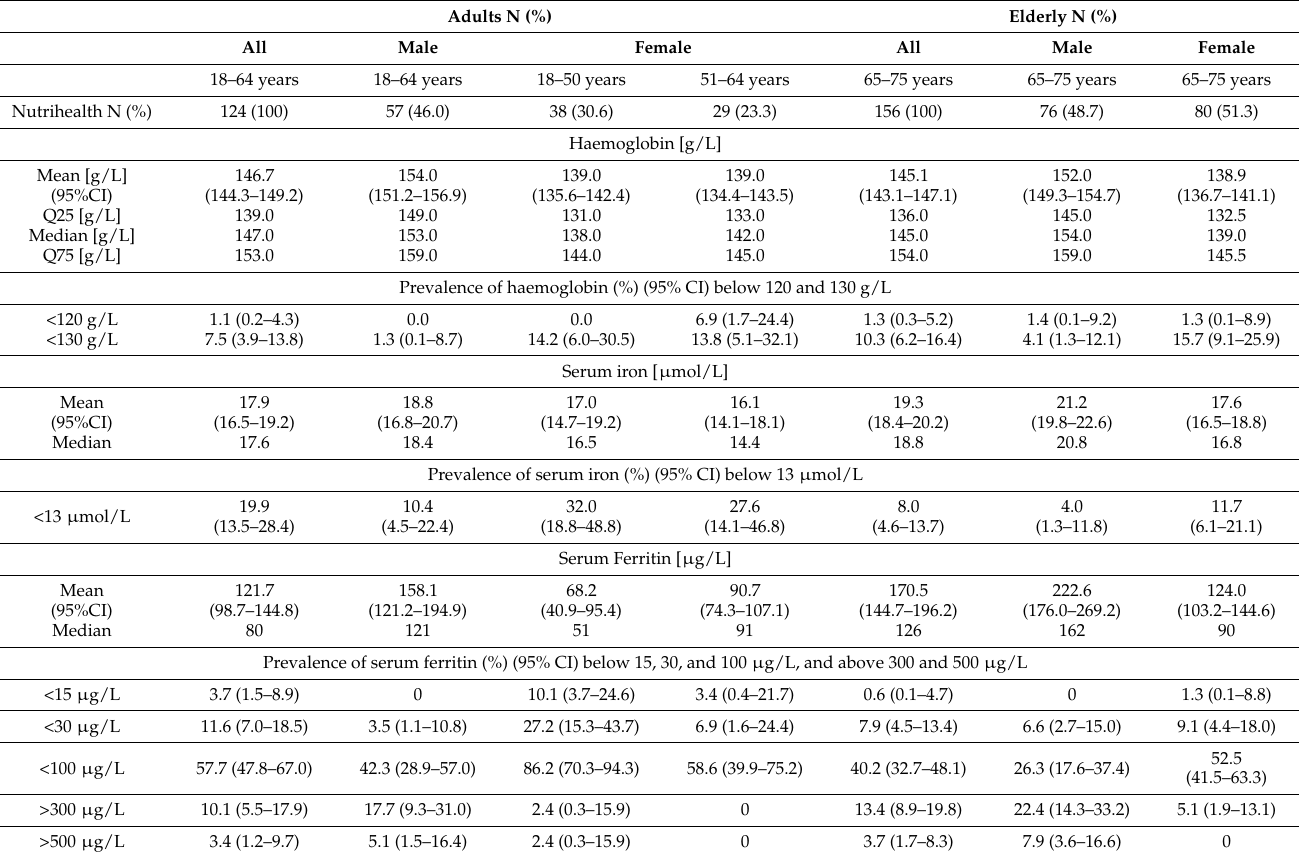
Table 3. Population-weighted mean haemoglobin, serum ferritin, and serum iron concentration, and the prevalence of low haemoglobin, low serum iron, and low/high ferritin for adults and the elderly in the Nutrihealth study (N = 280). Adults N (%) Elderly N